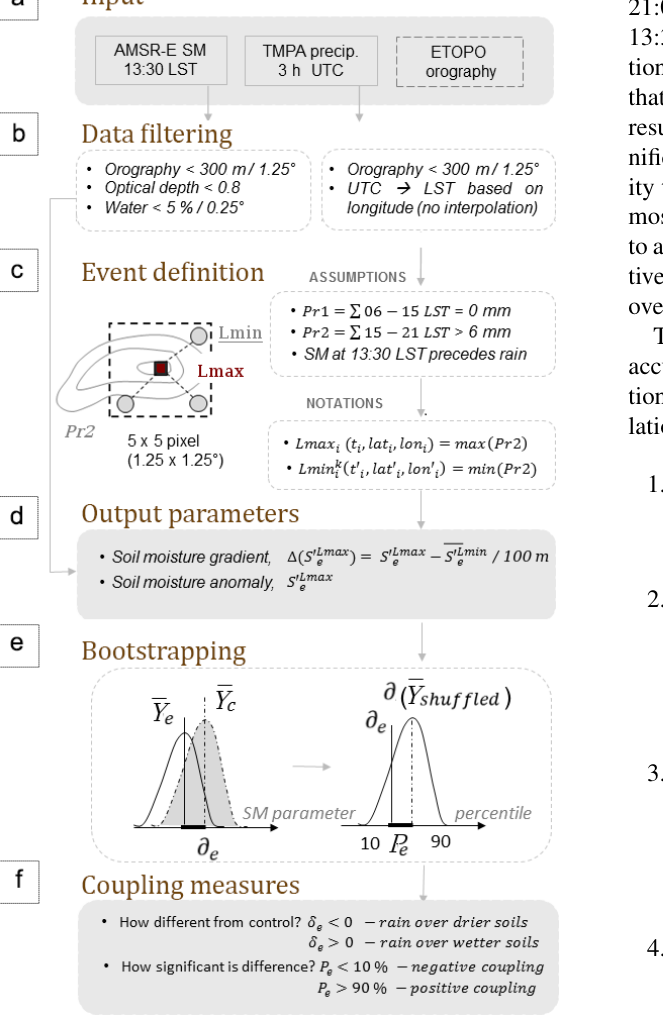
Figure 2. Schematic of data post-processing and statistical frame- work protocol implemented in the